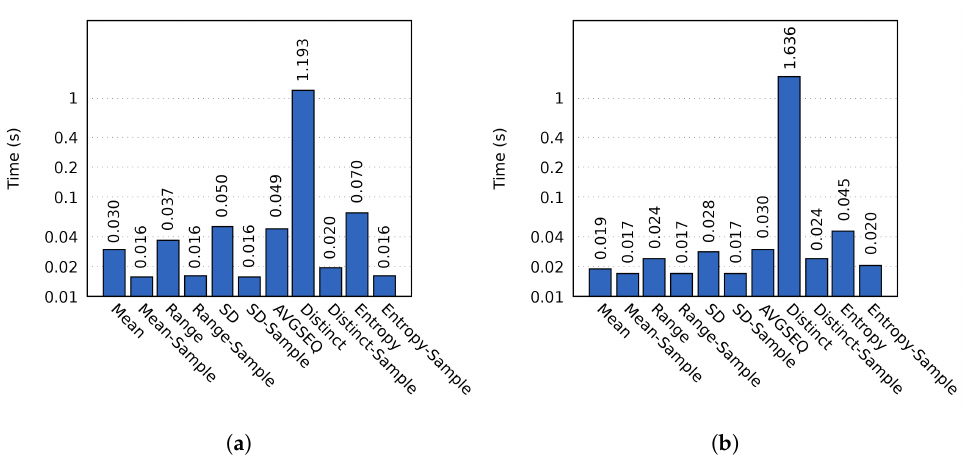
Figure 5. The importance calculation times on ( a ) cluster A and ( b ) cluster B using the MF data set. The y-axis has a logarithmic